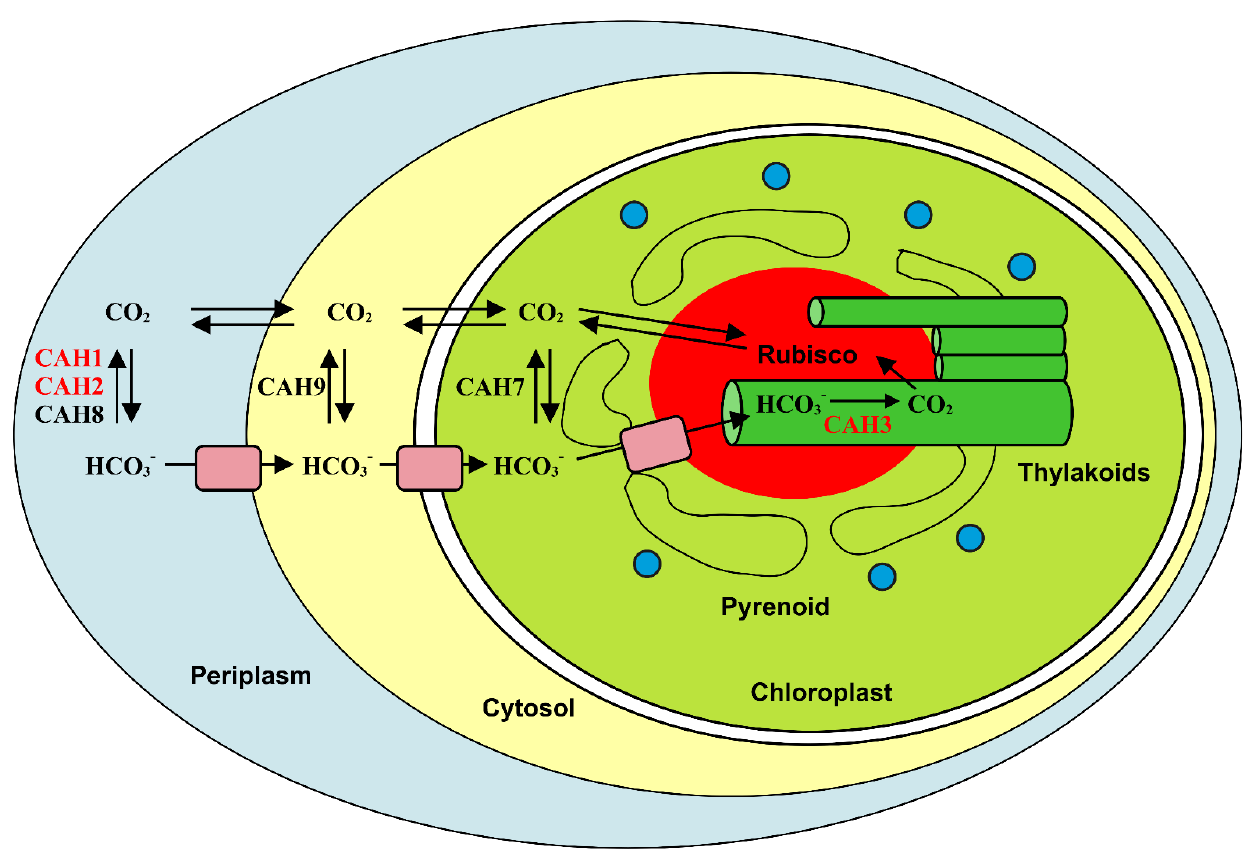
Figure 1. Representation of CCM in C. reinhardtii showing the subcellular localization of the different CAs involved. CAH1, CAH2, and CAH3 belong to the α -class and are shown in red, while CAH7, CAH8, and CAH9 are β -CAs and are colored in black. CAH7 localization is not fully demonstrated. Pink rectangles represent bicarbonate transporters whereas blue circles symbolize low CO 2 -inducible proteins (β -CAs).